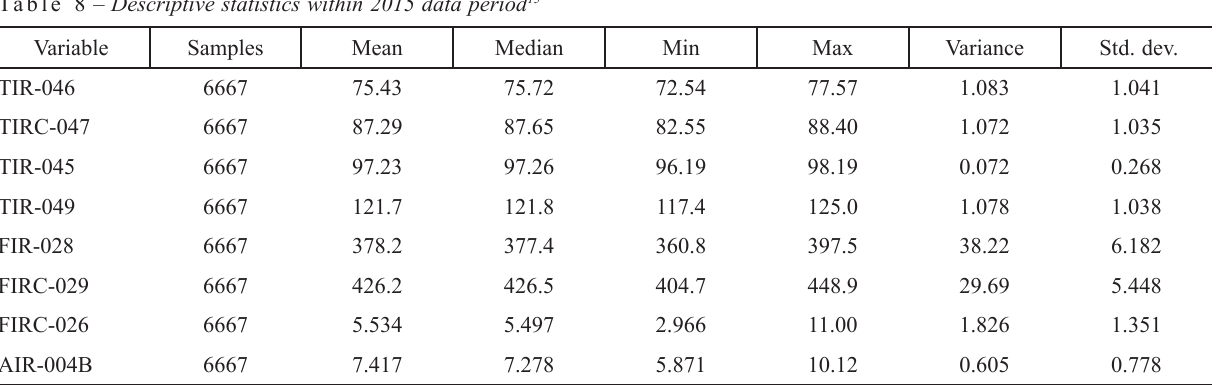
Table 8 – Descriptive statistics within 2015 data period 15